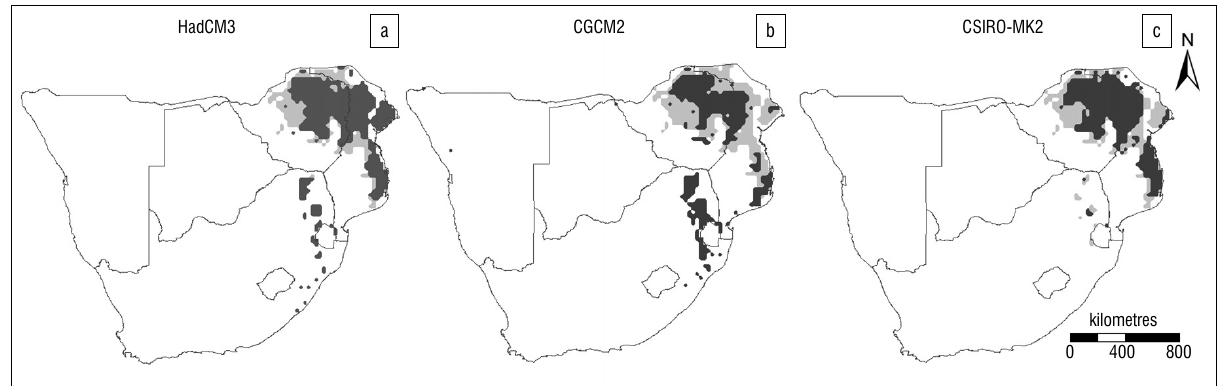
Figure 5: Predicted future (2050) ecological niche for Brachystegia spiciformis woodland in southern Africa (dark grey) under the A2a scenario across three general circulation models: (a) HadCM3, (b) CGCM2 and (c) CSIRO-MK2. The present-day ecological niche (light grey) is included